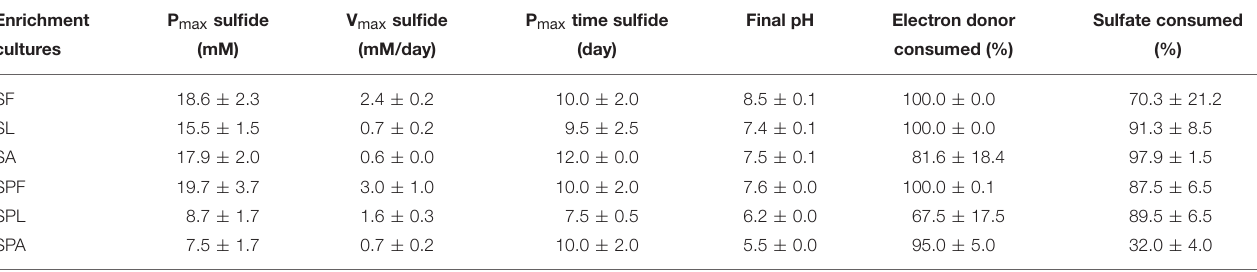
TABLE 2 | Production of sulfide and consumption of electron donors and sulfate in the sulfate-reducing enrichment cultures from marine sediment (as inoculum) using sodium sulfate or phosphogypsum as sulfate